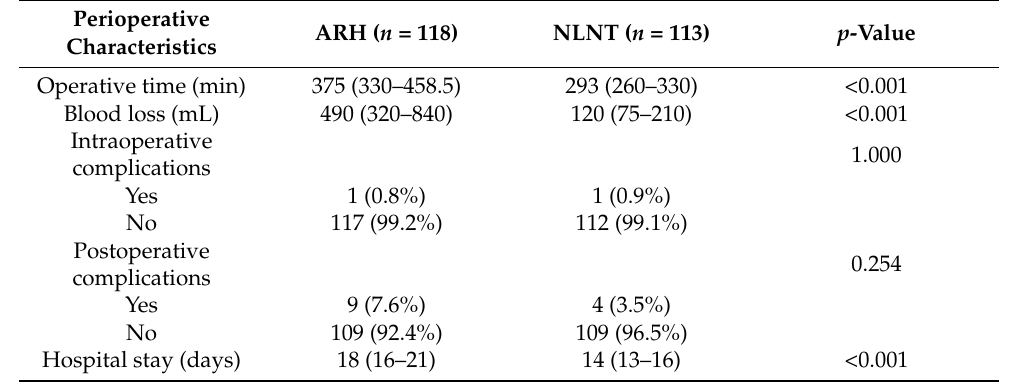
Table 2. Perioperative characteristics.